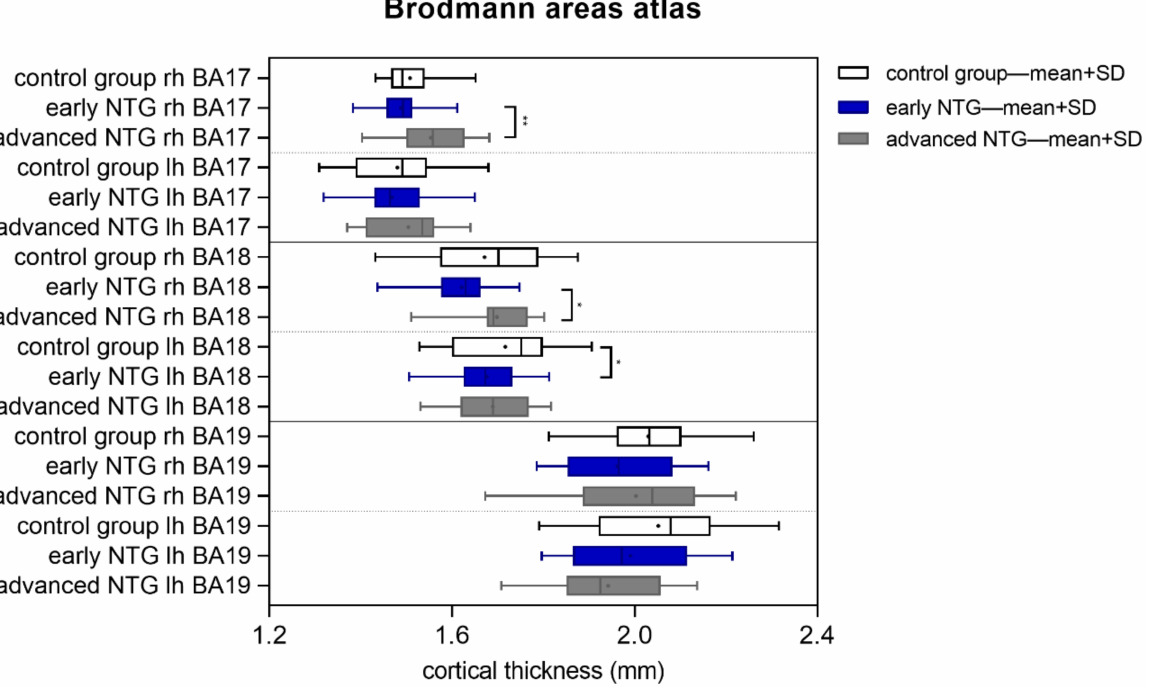
Figure 2. Cortical thickness analysis results in the control group and NTG patients (in early and advanced stage) measured according to the Brodmann area atlas in primary visual cortex (V1–BA17), secondary visual cortex (V2–BA18), and middle temporal visual area (V5/MT–BA19) (* p < 0.05, ** p <